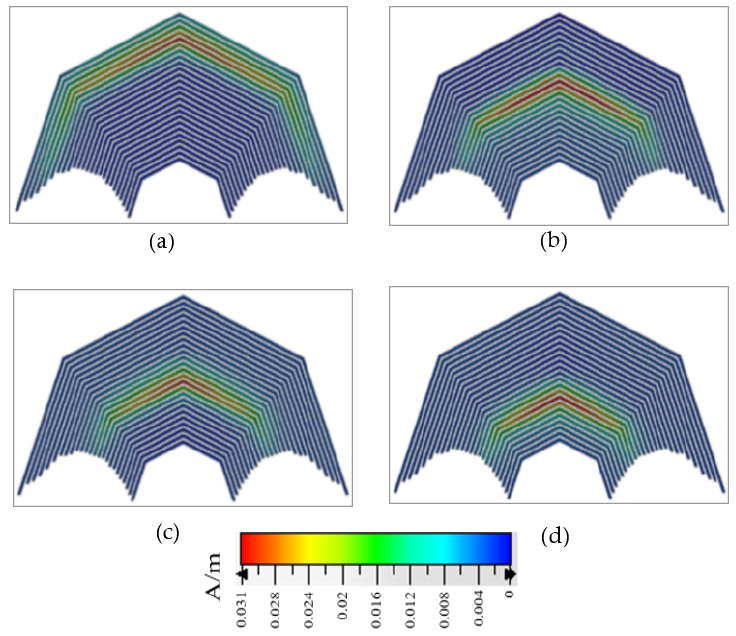
Figure 6. Surface current distribution at: ( a ) 4 GHz; ( b ) 6 GHz; ( c ) 7 GHz; ( d ) 8 GHz.